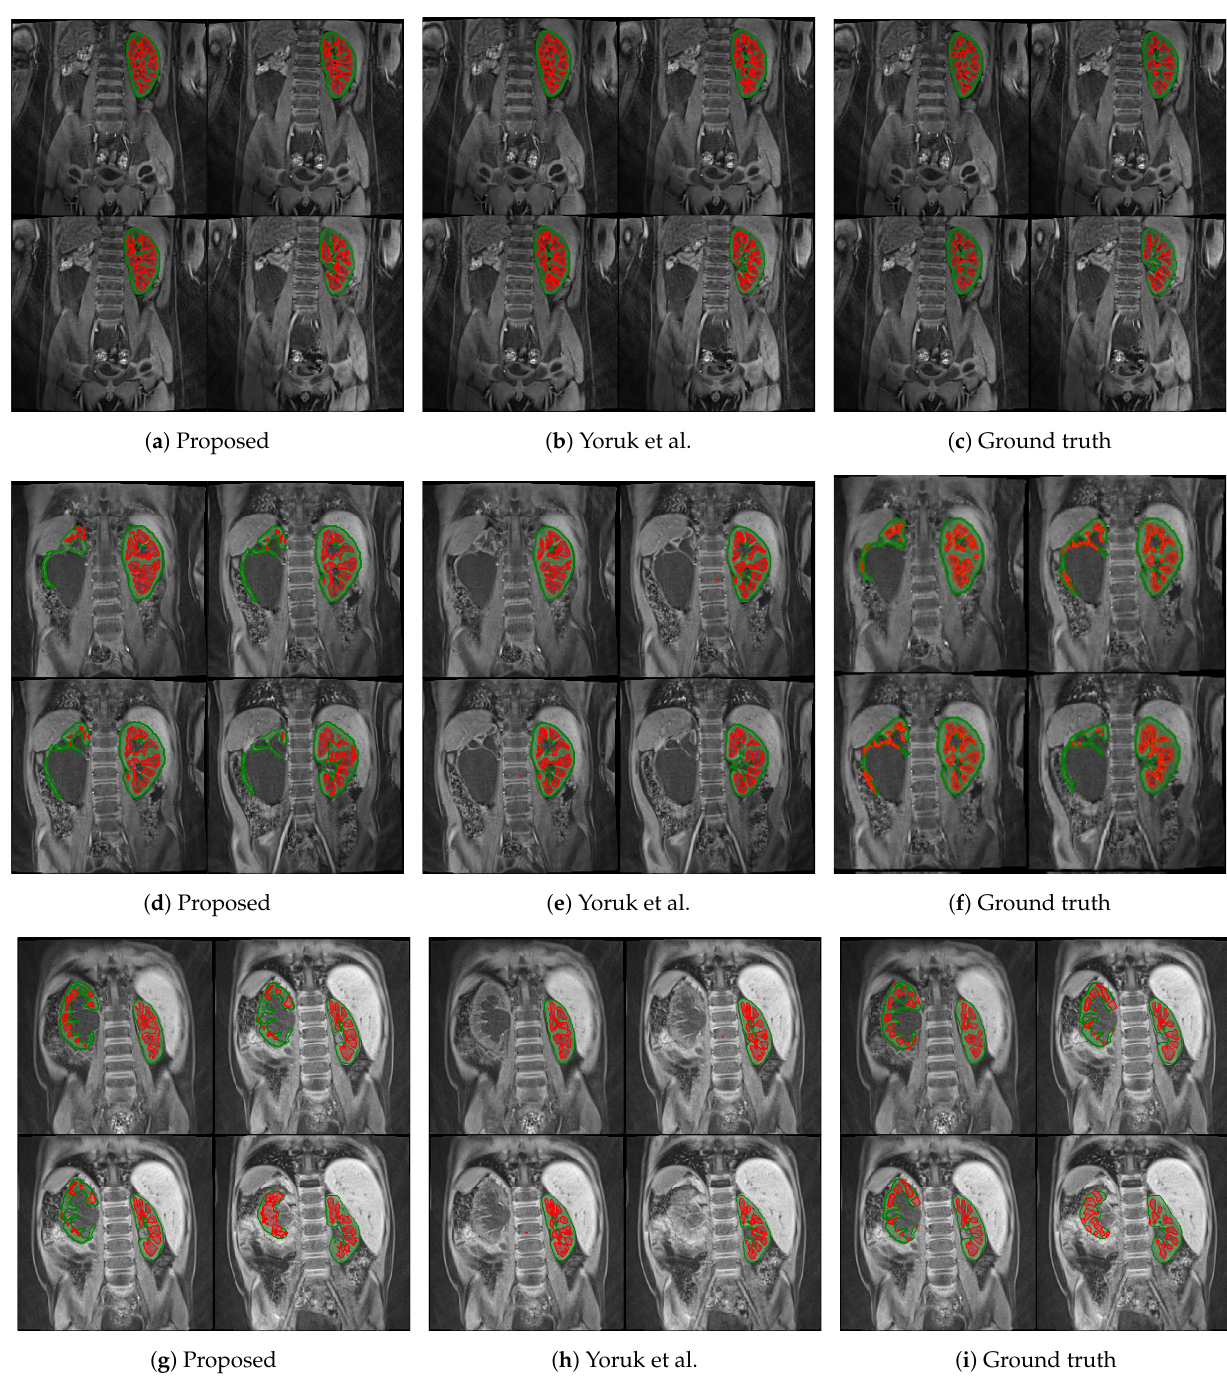
Figure 6. Medulla and cortex segmentation results of three different clinically “abnormal” kidneys. The first column ( a , d , g ) shows the results from the proposed approach; the second column ( b , e , h ) shows the respective results using the baseline approach from Yoruk et al. [16]; the third column ( c , f , i ) shows the respective ground